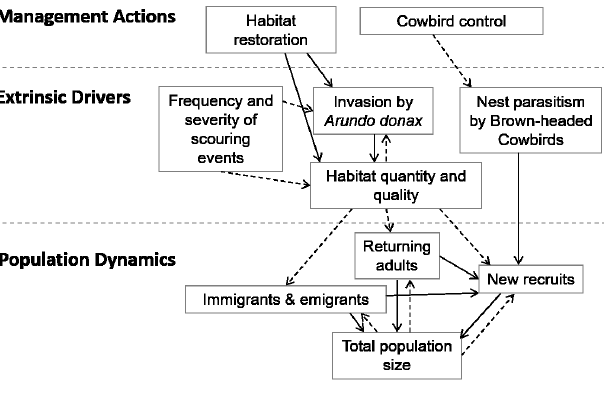
Fig. 1 . Conceptual model of Least Bell’s Vireo population on the Santa Clara River. Arrows signify interactions, processes, and/or feedbacks between system elements that would be parameterized in a full system model. Solid arrows indicate parameters that are either well understood (or currently measured) such that if the element in the arrow origin was suitably estimated, the effect on the terminal element should be estimable. Dashed arrows indicate interactions that are either theoretical or more difficult to estimate at